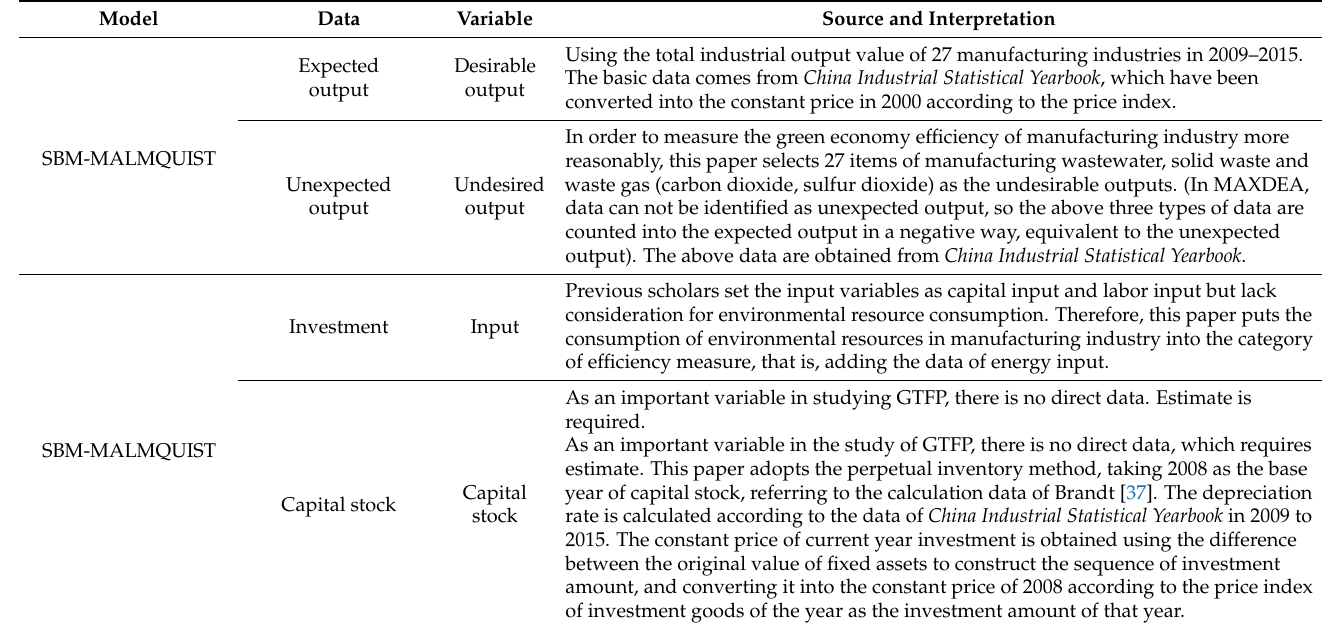
Table 1. Interpretation of main